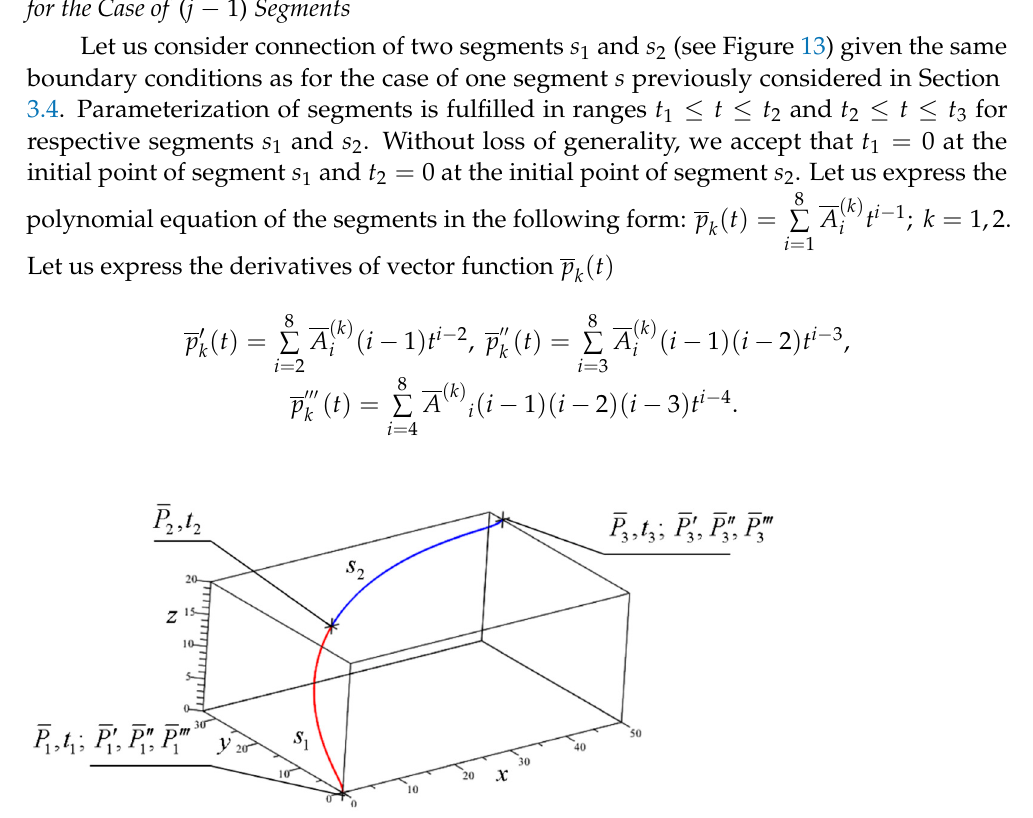
Figure 13. Seventh-degree Hermite spline curve of two segments.